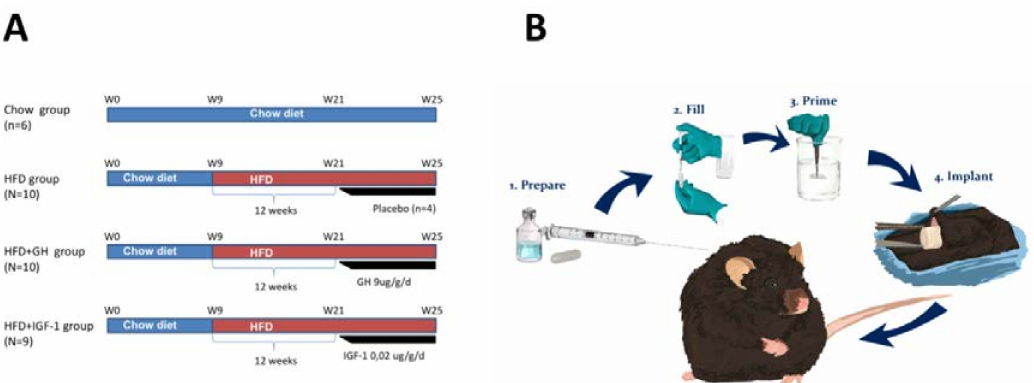
Figure 5. ( A ) Schematic representation of experimental approach on each of the study groups. ( B ) Implantation of osmotic pumps. Osmotic pumps were implanted subcutaneously in C56BL6 mice after 12 weeks of high fat diet for continuous subcutaneous infusion of placebo, growth hormone (GH) or insulin growth factor type 1 (IGF-1) respectively. HFD: High fat